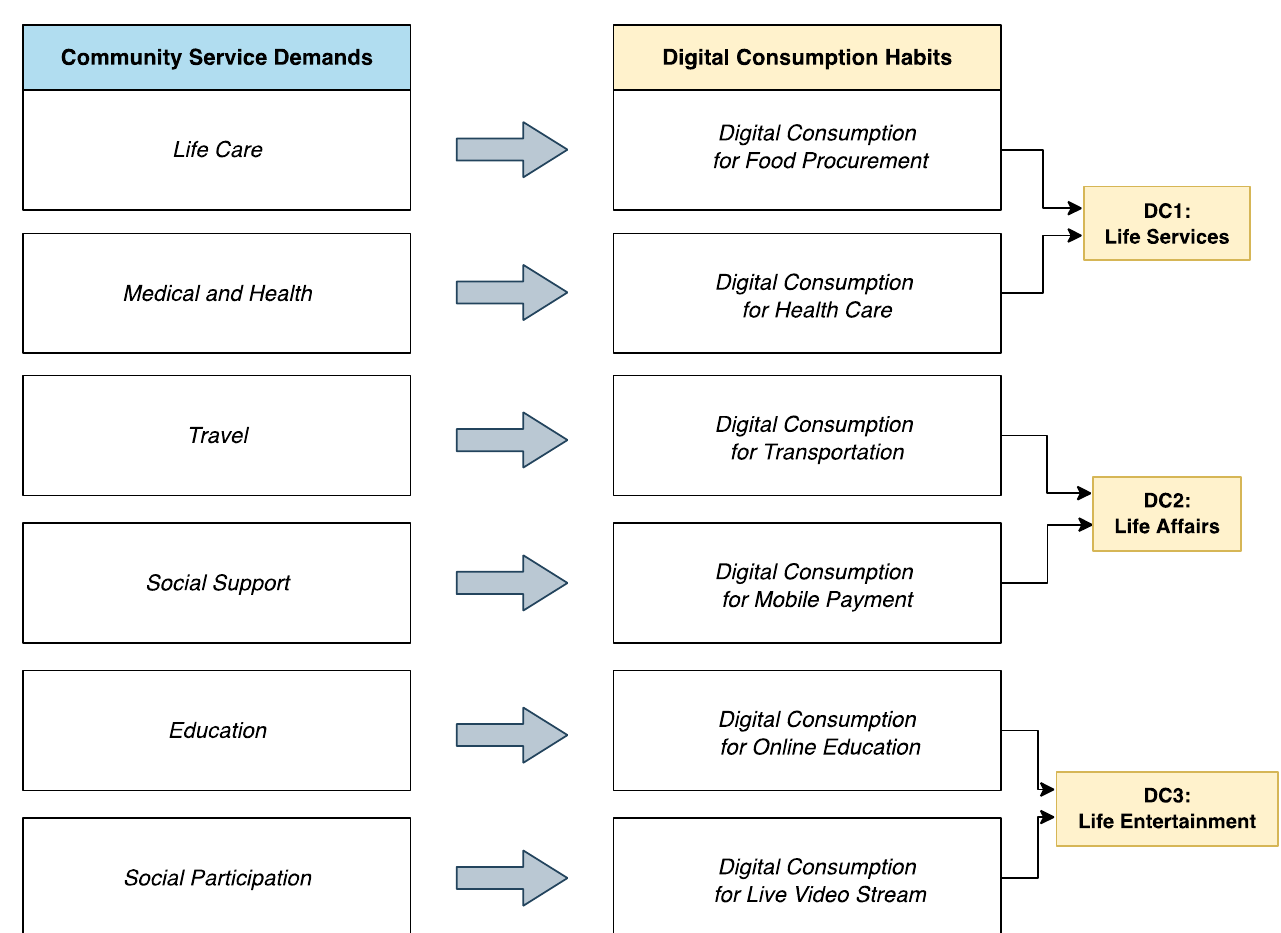
Figure 2. Relationship between the community service demand and digital consumption habits.